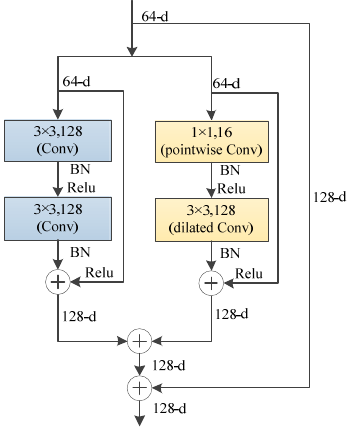
Figure 8. Improved fused dilated convolution module.